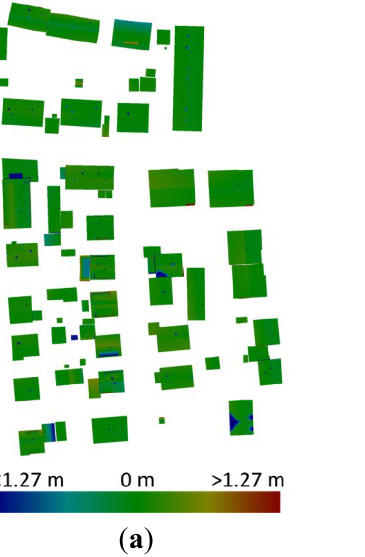
Figure 18. Inconsistency between primitives and buildings. ( a ) DSM difference between the reference and the result; ( b ) Evaluation of building reconstruction on a per-pixel